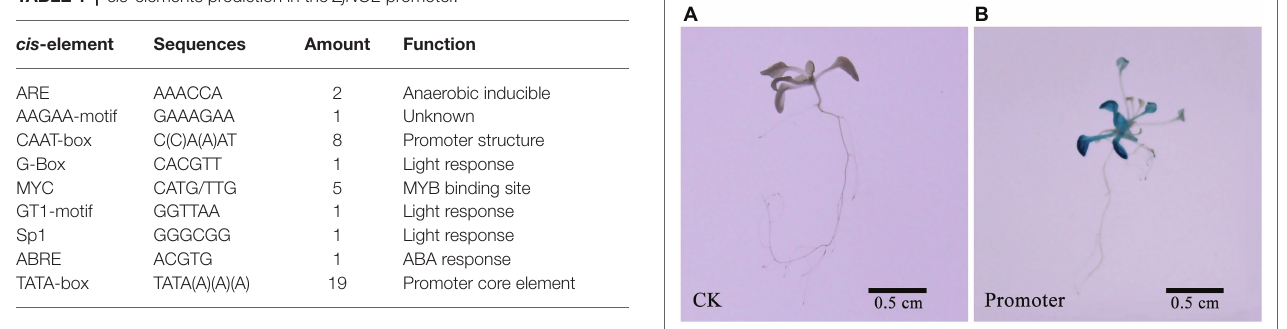
TABLE 1 | cis -elements prediction in the ZjNOL